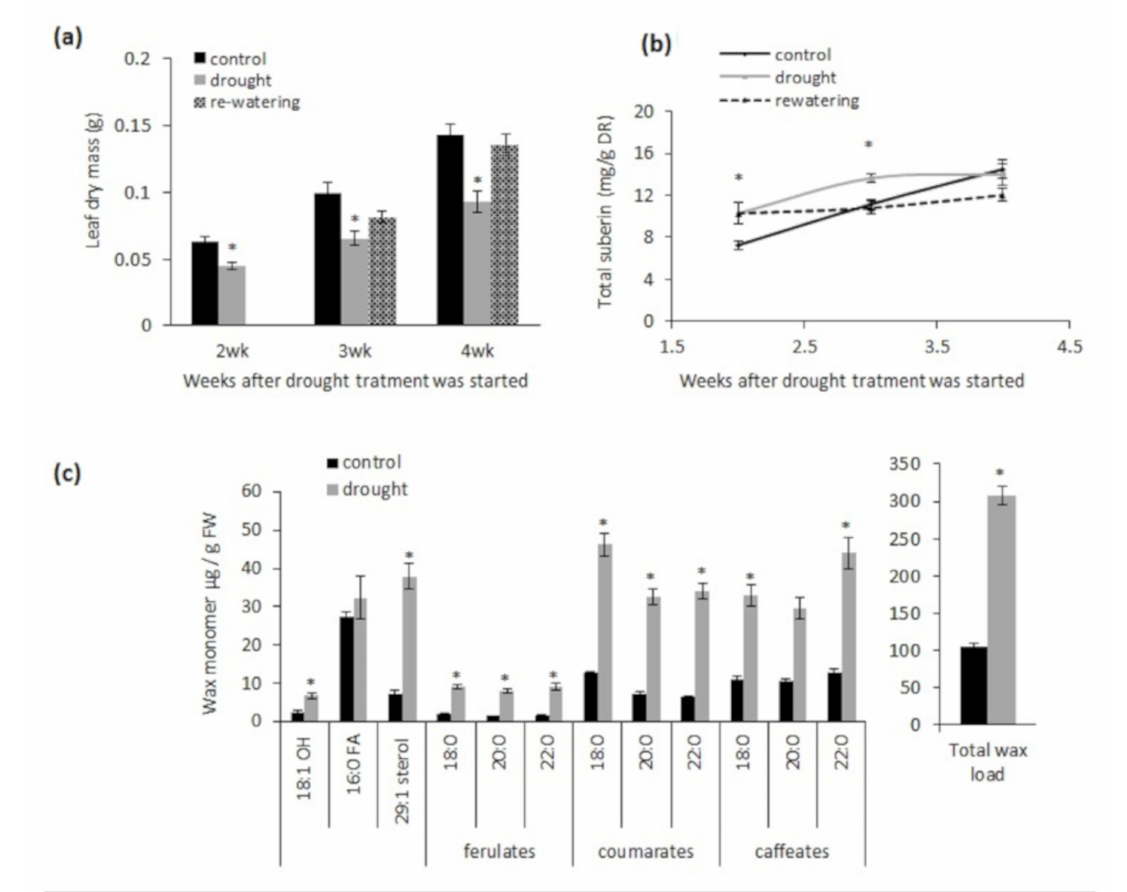
Figure 2. Comparison of leaf dry biomass, root suberin content, and root suberin-associated wax amounts in wild-type (Col-0) plants. ( a ) Leaf biomass, ( b ) root poly-aliphatic suberin at different time points under control, drought, and re-watering conditions, and ( c ) chloroform-extractable root wax amounts from 5-week-old tap root surfaces, 3 weeks drought stressed versus control. The drought treatment was at 5% ( v / v ) water level. In ( a , b ), plants were subjected to re-watering (20% water level) after two weeks of drought treatment (i.e., 3 weeks = 2 weeks drought + 1 week re-watering and 4 weeks = 2 weeks drought + 2 weeks re-watering). Data points shown are mean values in grams of leaf dry mass from 10 replicate plants ± SE ( a ), milligrams of total poly-aliphatic suberin per gram of delipidated dry residue from five replicate samples (a replicate consisted of roots from a pool of 4 plants) ± SE ( b ), and micrograms of total root wax per gram of fresh weight from 4–5 replicate samples (a replicate consisted of 10 tap roots) ± SE ( c ). Asterisks indicate p < 0.05 by Student’s t -test comparing the values of the control and treatment. 1-OH, primary fatty alcohol; FA = free fatty